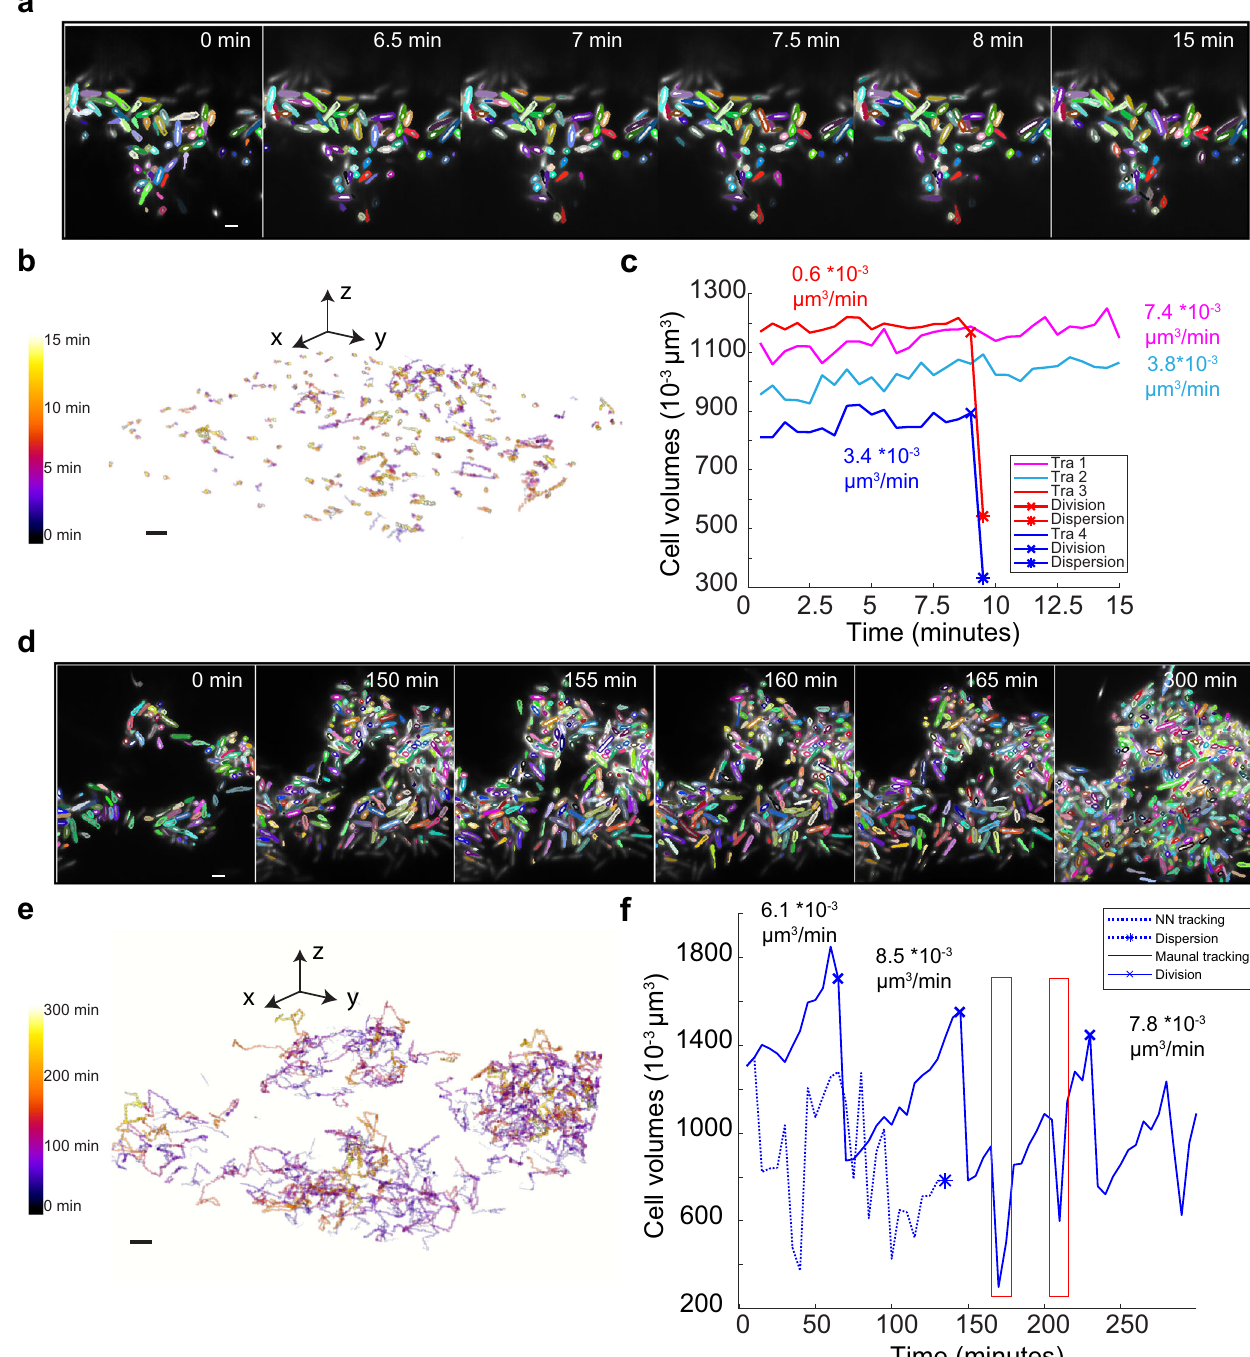
Fig. 4 Multi-cell tracking of experimentally acquired S. oneidensis bio fi lm images. a Experimentally acquired fl uorescence time-lapse images of a growing S. oneidensis bio fi lm with overlaid single-cell segmentation contours. Images were acquired every 30 s for 15 min. Corresponding cells in different frames are displayed in the same color. Scale bar is 2 µm. b Individual cell trajectories in the bio fi lm shown in a . Cells move very little during the short 15-min imaging time. Scale bar is 1 µm. c Cell volumes over time for four example cells. Cell division and dispersion events are indicated for each trajectory. Single-cell growth rate was measured by calculating the slope of linearly fi tted line for each curve. d Experimentally acquired fl uorescence time-lapse images of a growing S. oneidensis bio fi lm with overlaid single-cell segmentation contours. Images were acquired every fi ve minutes for fi ve hours. Corresponding cells in different frames are displayed in the same color. Scale bar is 2 µm. e Individual cell trajectories in the bio fi lm shown in a . Cell displacements are more pronounced over the 5-h imaging time. Scale bar is 1 µm. f Evolution of cell volumes over time for a single selected cell. The solid line represents a manually annotated trajectory, and the dashed line represents the nearest neighbor tracking trajectory of the same initial cell. Cell division and dispersion events are indicated on each trajectory. The single-cell growth rate was measured by calculating the slope of the trajectory segment between consecutive cell division events. The red arrow and the boxes indicate periodic underestimation of the cell volume due to